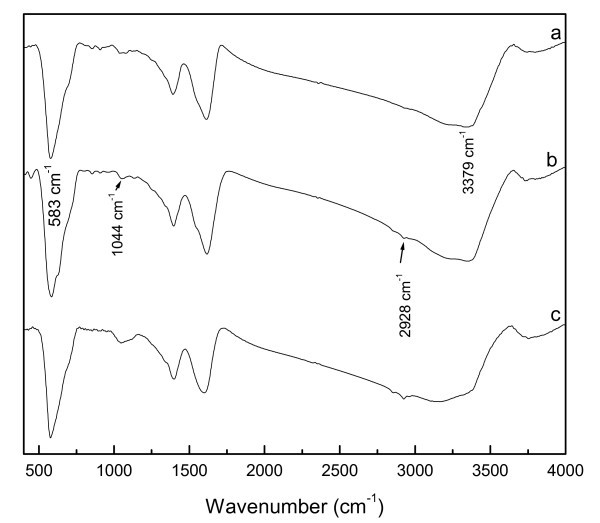
FT-IR spectra of the Fe3O4@PPy deposits prepared under different amounts of pyrrole monomer at 160°C: (a) 0.1 mL, (b) 0.3 mL, (c) 0.5 mL.